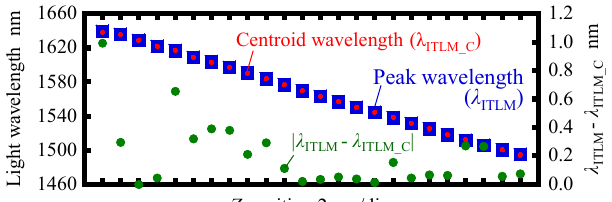
Figure 13. Peak wavelength λ ITLM and centroid wavelength λ ITLM_C of I ITLM encoded from the normalized chromatic confocal output obtained at each Z-position of the target mirror by the chromatic confocal probe with the proposed off-axis differential method.